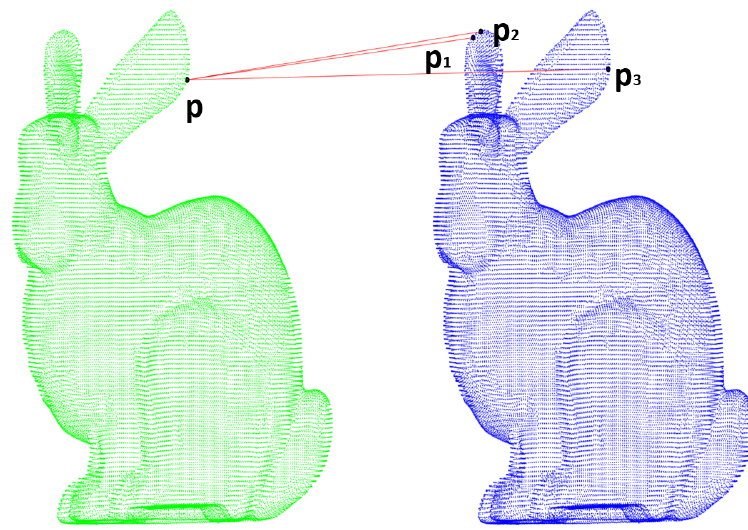
Figure 2. The process of key points matching in two point